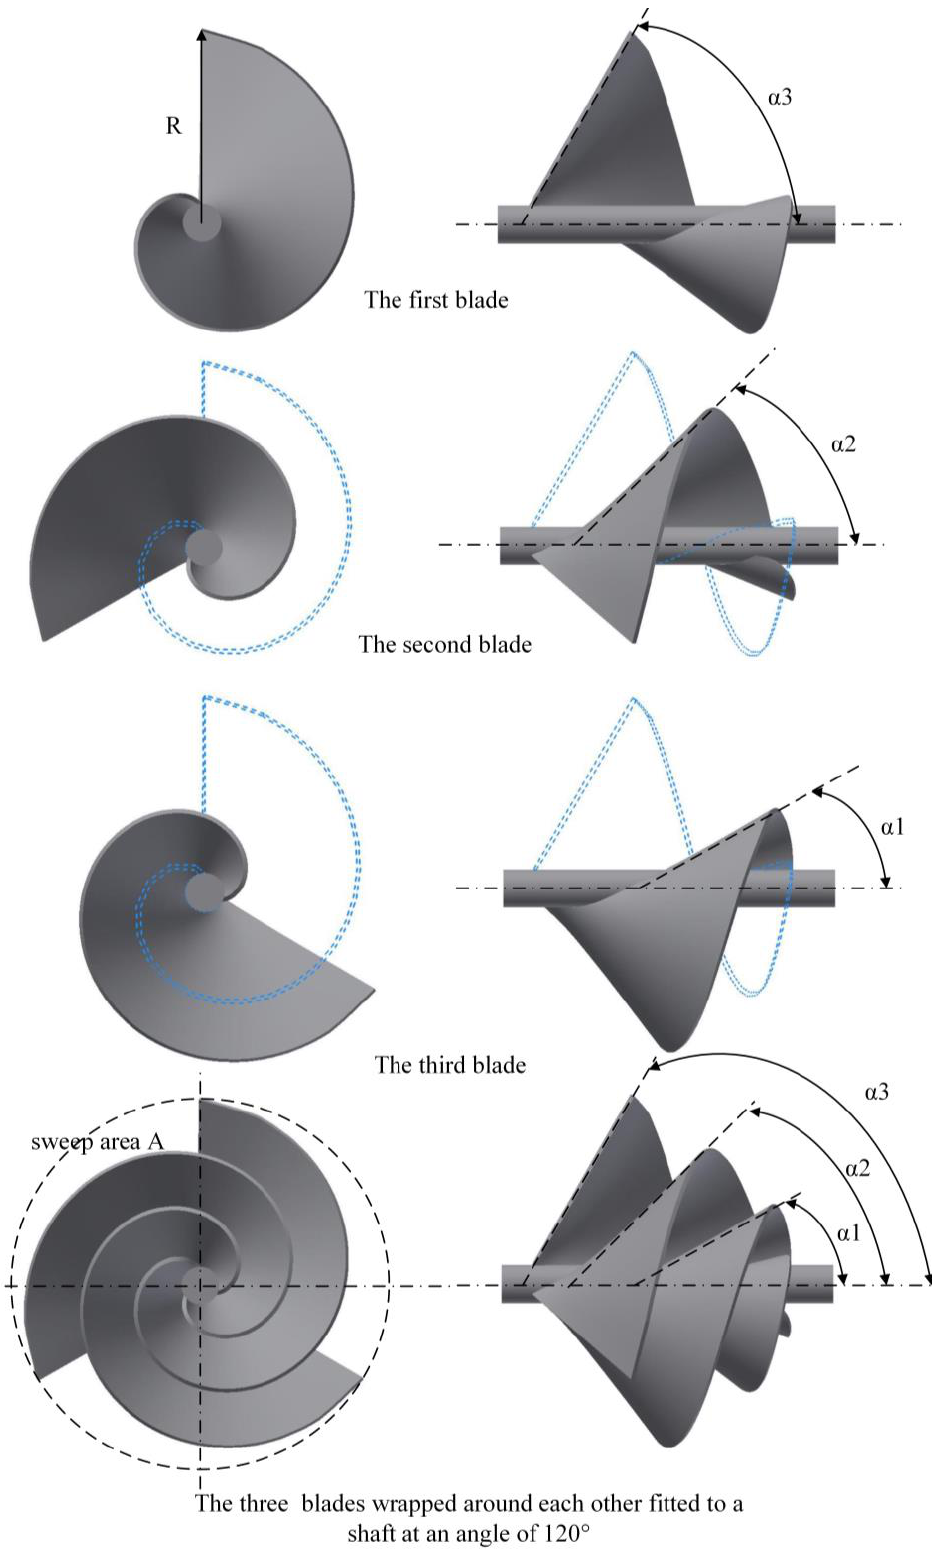
Figure 3. Definition of the blade angle on an ASWT rotor.